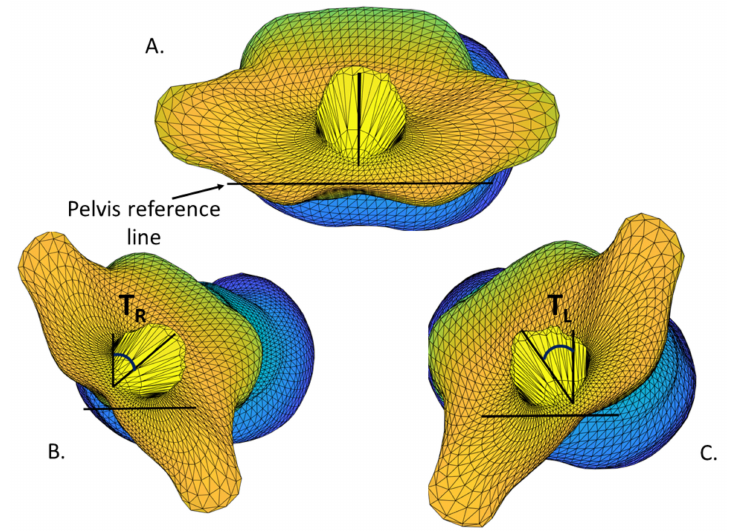
Figure 2. Axial views of torso mesh after alignment to pelvis axis. Twisting angle was measured between the sagittal plane and the line connecting C7 and jugular notch landmarks for each pose: ( A ) forward position; ( B ) maximum right twist; ( C ) maximum left